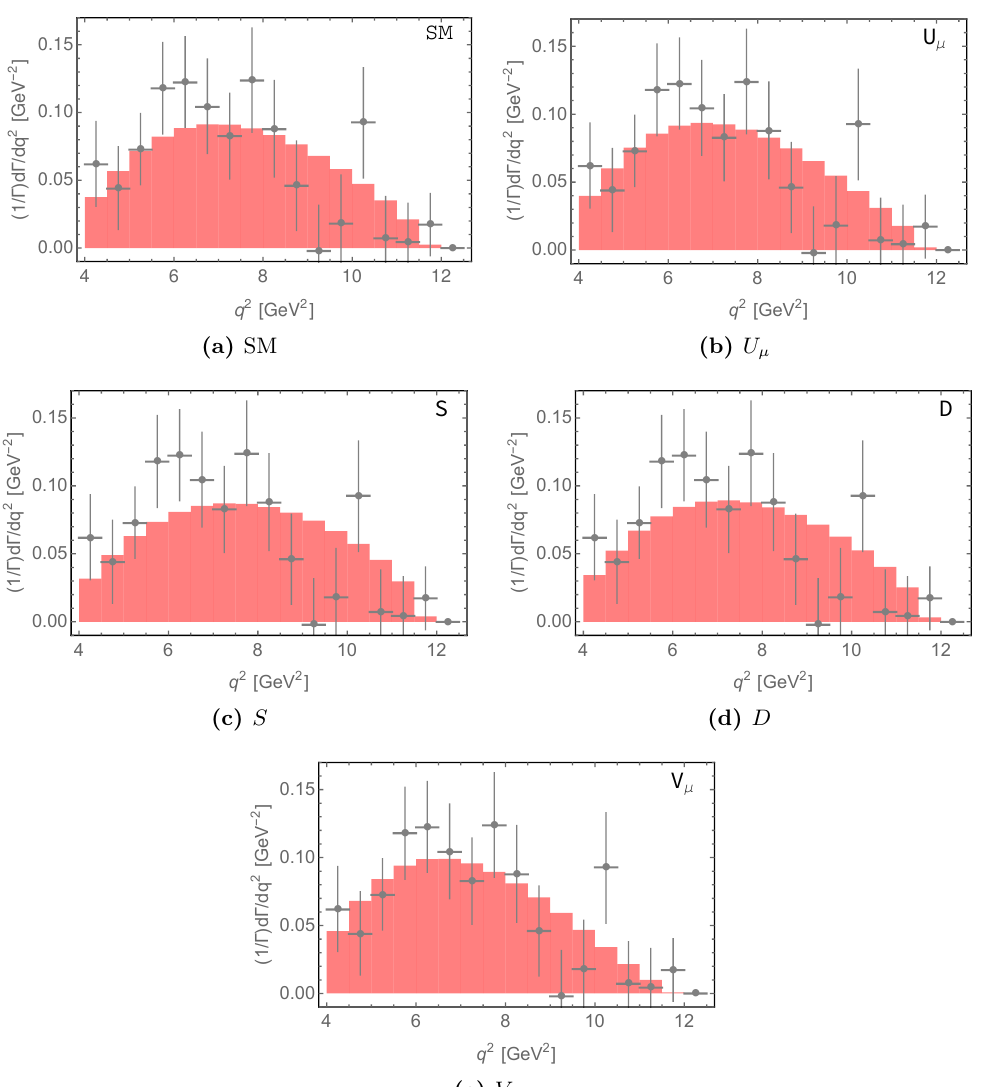
Figure 3. Normalized q 2 distribution of (cid:0)[ B ! D(cid:28)(cid:23) ]. Data points and error bars are taken from ref.